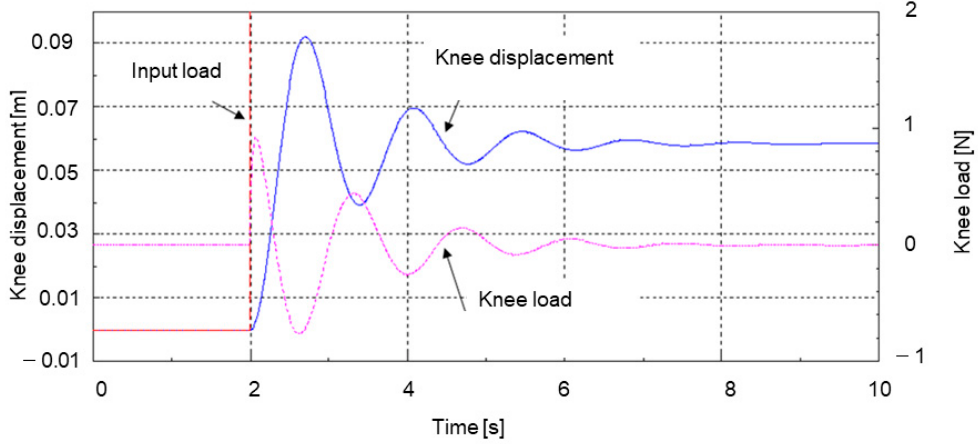
Figure 14. Fundamental model calculation result without device. Figure 15 shows the device inserted. The device k = 200 N/m and c = 50 kg/s. Figure 15 is used as the basis of the device element study.